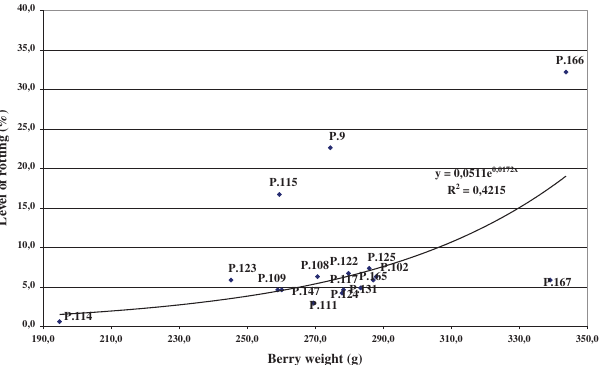
Figure 3. Correlation between the berry weight (100 berries) and level of rotting of clones of ‘Kadarka’ (Szekszárd - Batti field, 2009-2011)